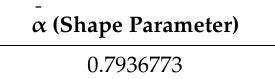
Table A17. MNIG Shape parameter α for Vector 5: Daqing, Urals, SHCOMP, RTSI. ¯ α (Shape Parameter)